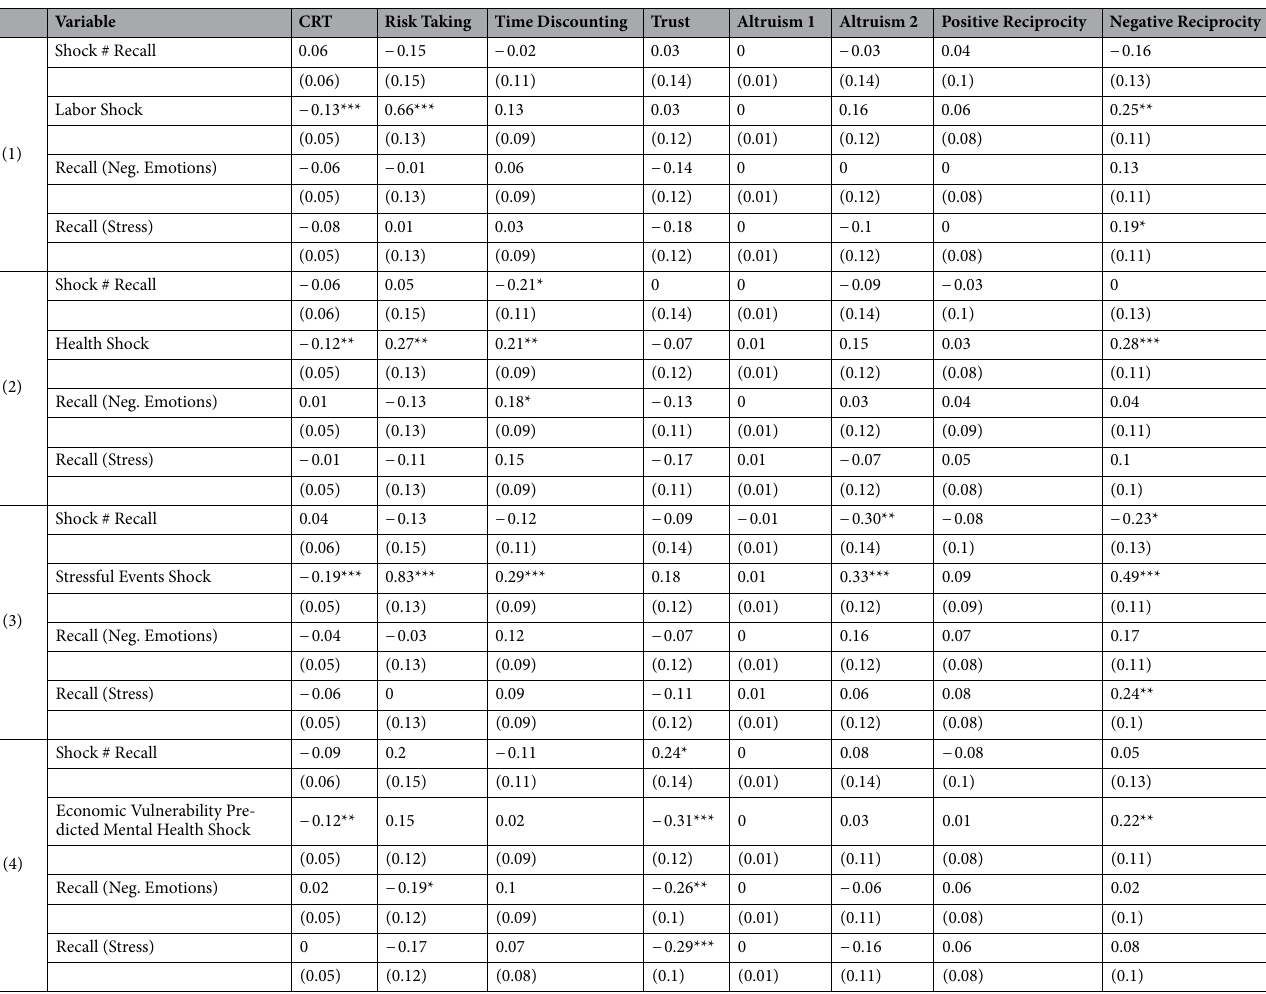
Table 1. Coefficients for the interaction terms for each of the shock variables per dependent variable. Each of the cells correspond to the coefficients and their standard errors in parenthesis from regressions, including an interaction term between shock and recalls, a dummy for shock and dummies for each of the recalls. (1)-(4) corresponds to different regressions, each one with the full set of covariates. Source: longitudinal